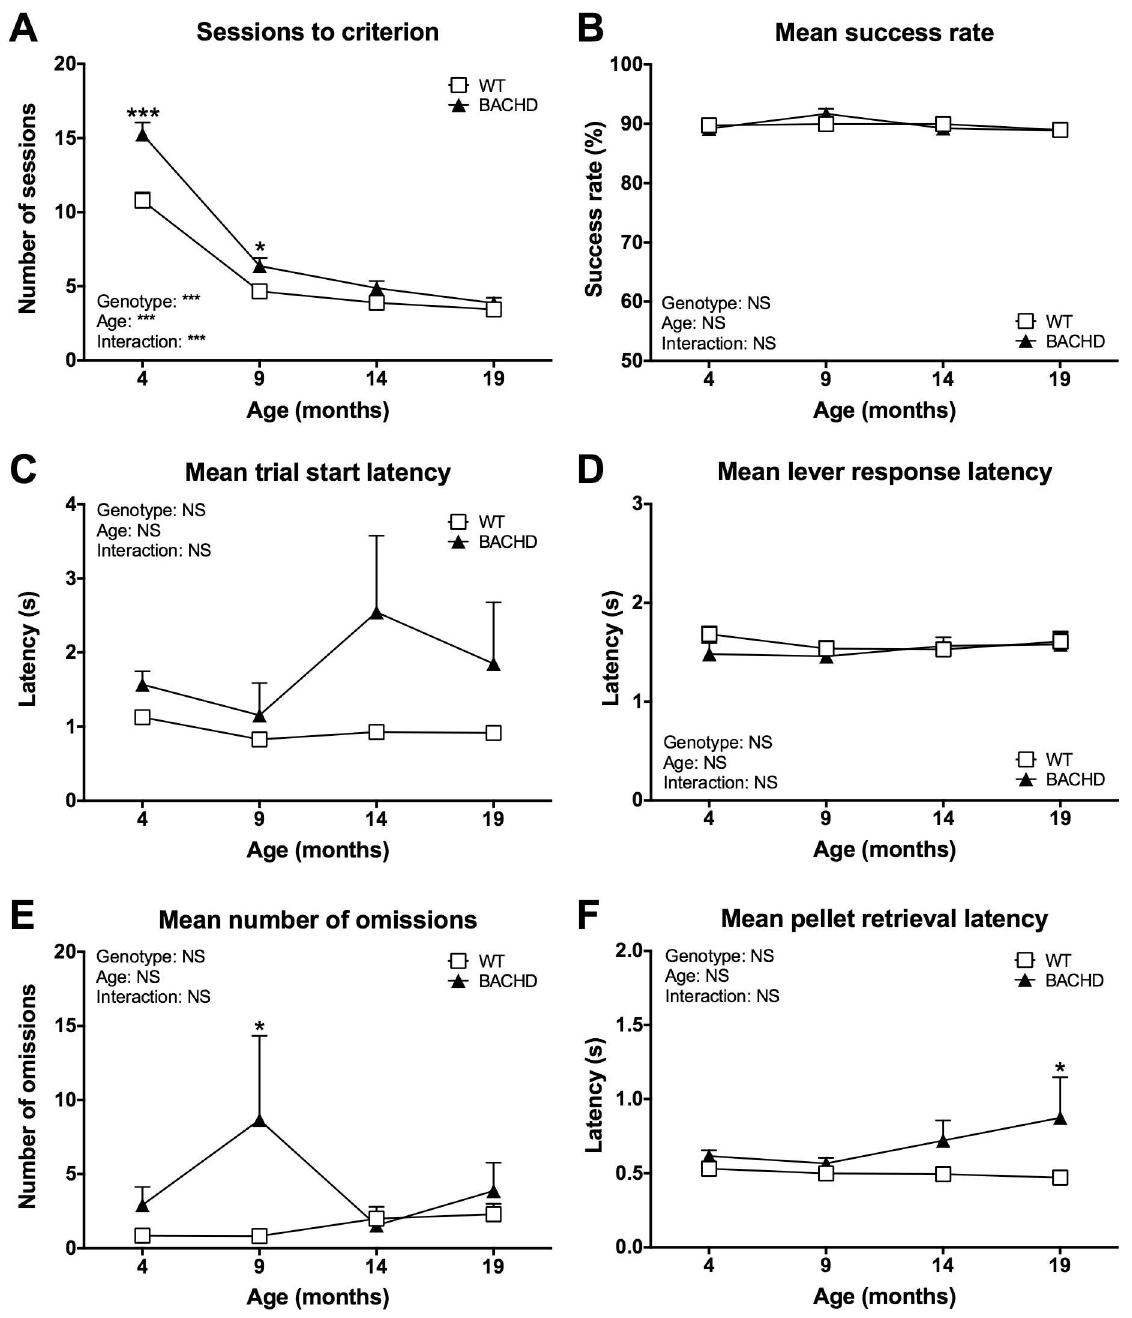
Fig 3. Age development of free alternation performance. The graphsshow the main readouts of the free alternation protocol over the four test ages. ( A ) shows the number of trainingsessions requiredfor reachingcriterion. ( B )–( F )show the mean performance of rats duringsessions where their success rate was at criterion level. Curves show group mean plus standarderror. Results from two-way repeatedmeasures ANOVA are shown insidethe graphs. Results from post-hoc analysisare indicatedin case significantgenotypedifferences were found. * ( P < 0.05) ** ( P < 0.01) *** ( P < 0.001).